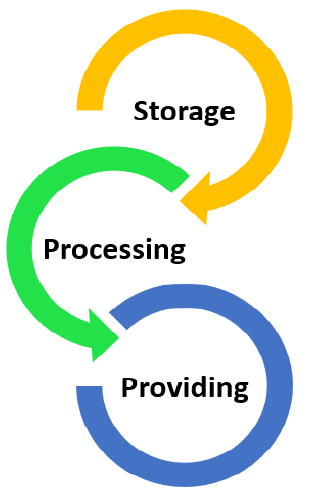
Figure 2. Basic concept of the proposed data management